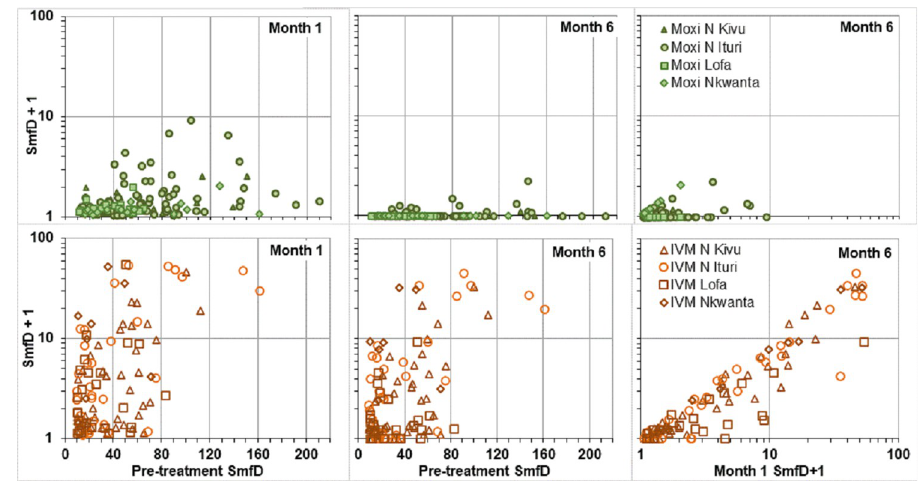
Fig 5. Skin microfilariae levels pre-treatment, at month 1 and at month 6 among participants who had detectable levels 1 month after treatment. SmfD: Skin microfilariae density, to allow displaying these data on a logarithmic scale, 1 was added to the SmfD values at Month 1 and 6.